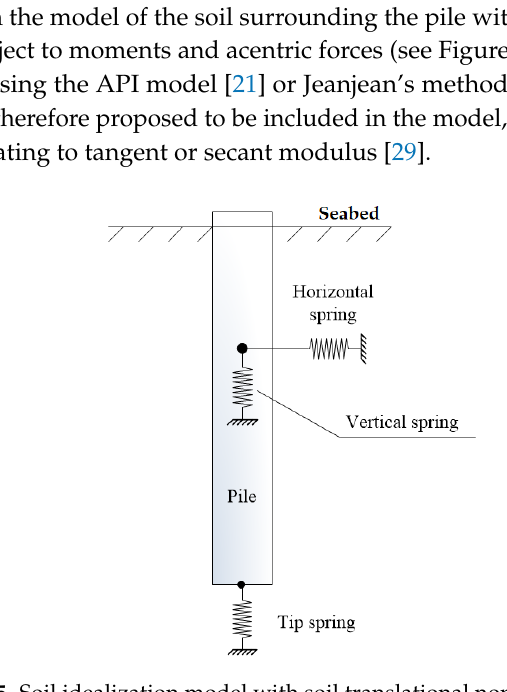
Figure 4. Typical tip load transfer–displacement (Q–Z) curve.